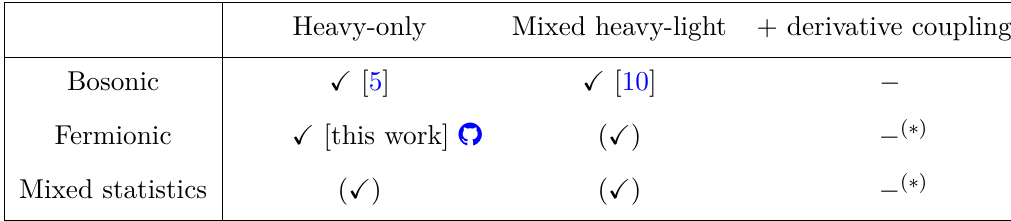
Table 1 . Status of the UOLEA. Entries marked by “ X ” are available in the form of operator structures built from the various types of couplings that appear in the quadratic Lagrangian. Entries marked by “ ( X ) ” are not available in the same form, but can be computed by plugging fermion couplings into the results of ref. [11] and evaluating Dirac matrix traces. Entries marked by “ − ” have not been computed in the literature, though the techniques for computing them are available. See text for